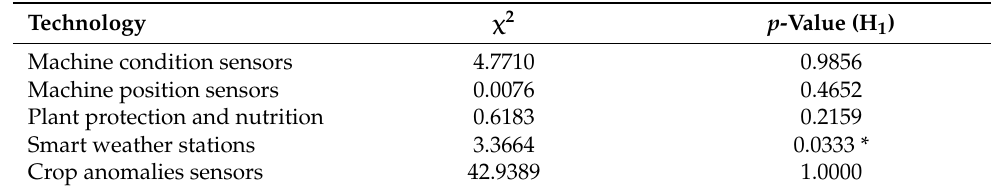
Table 1. Results of statistic evaluation for sensors in crop production.